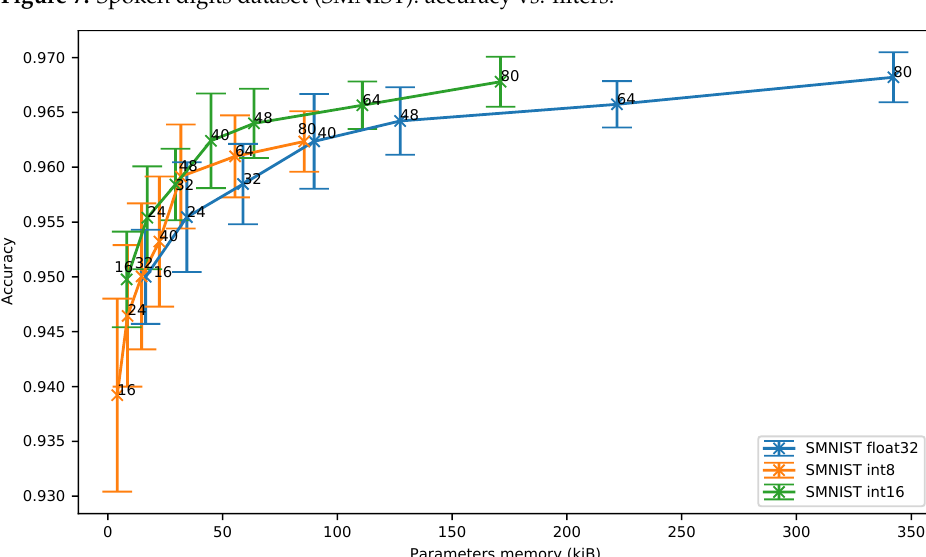
Figure 7. Spoken digits dataset (SMNIST): accuracy vs. filters.